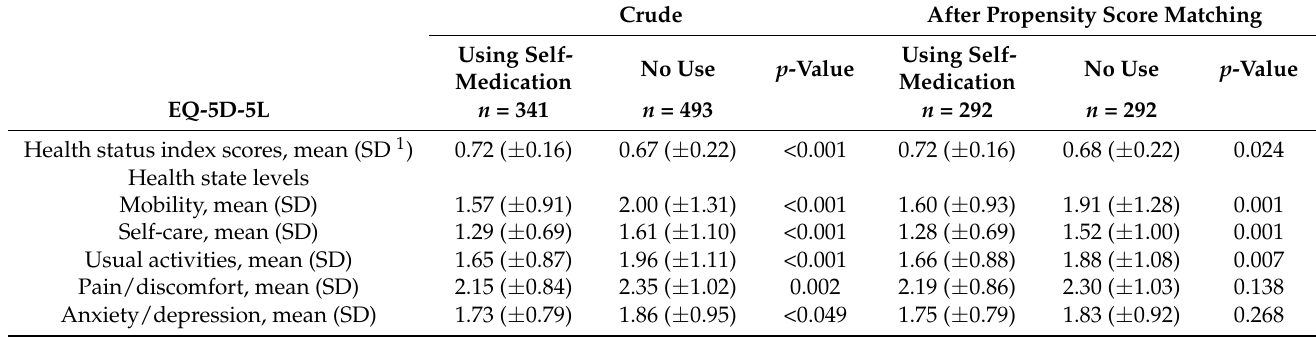
Table 2. Comparison of health status index scores and health state levels for the five dimensions of the EQ-5D-5L before and after propensity score